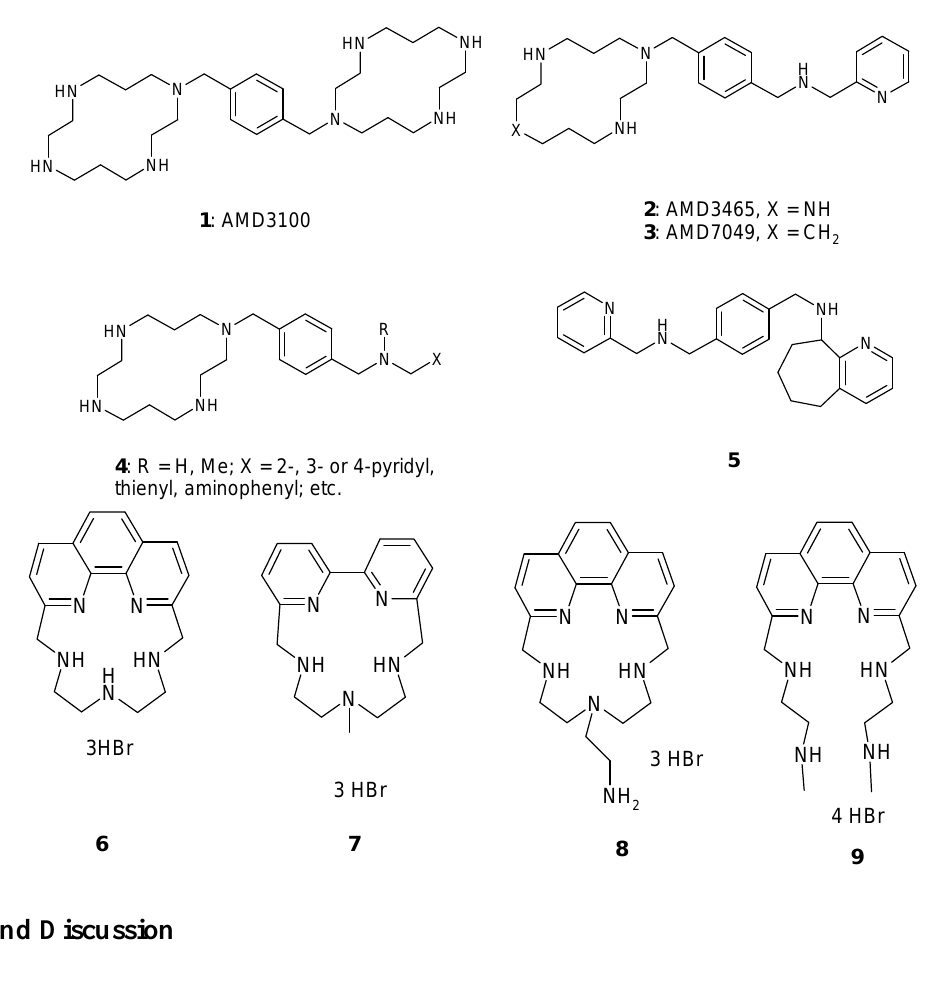
Figure 1. AMD3100 and related compounds plus the four newly synthesized macrocyclic